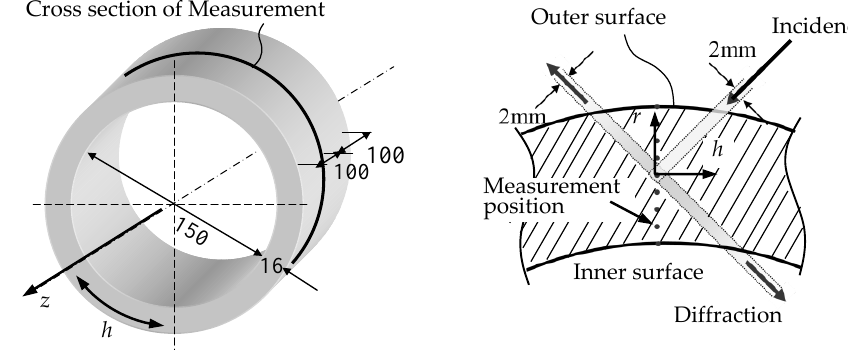
Figure 4. Schematics of neutron diffraction measurement position in hollow cylinder specimen [13].